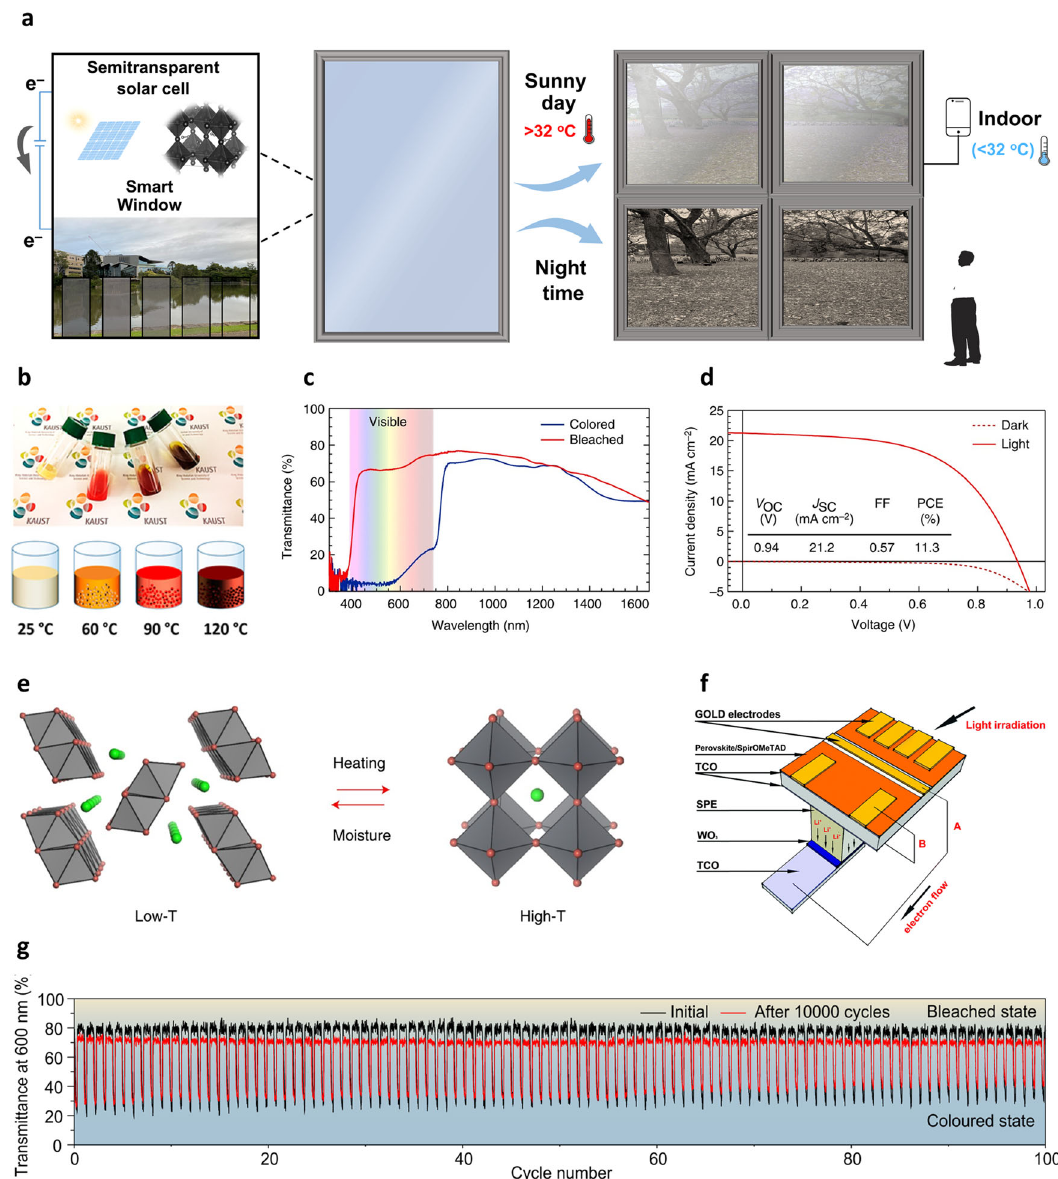
Fig. 5 Perovskite-based smart PV windows. a Schematic illustration of the key components of a self-powered smart photovoltaic window in hot and cold conditions. b Colors of MAPb(I 1 − x Br x ) 3 perovskite inks at temperatures of 25 °C, 60 °C, 90 °C and 120 °C. b Adapted with permission from ref.